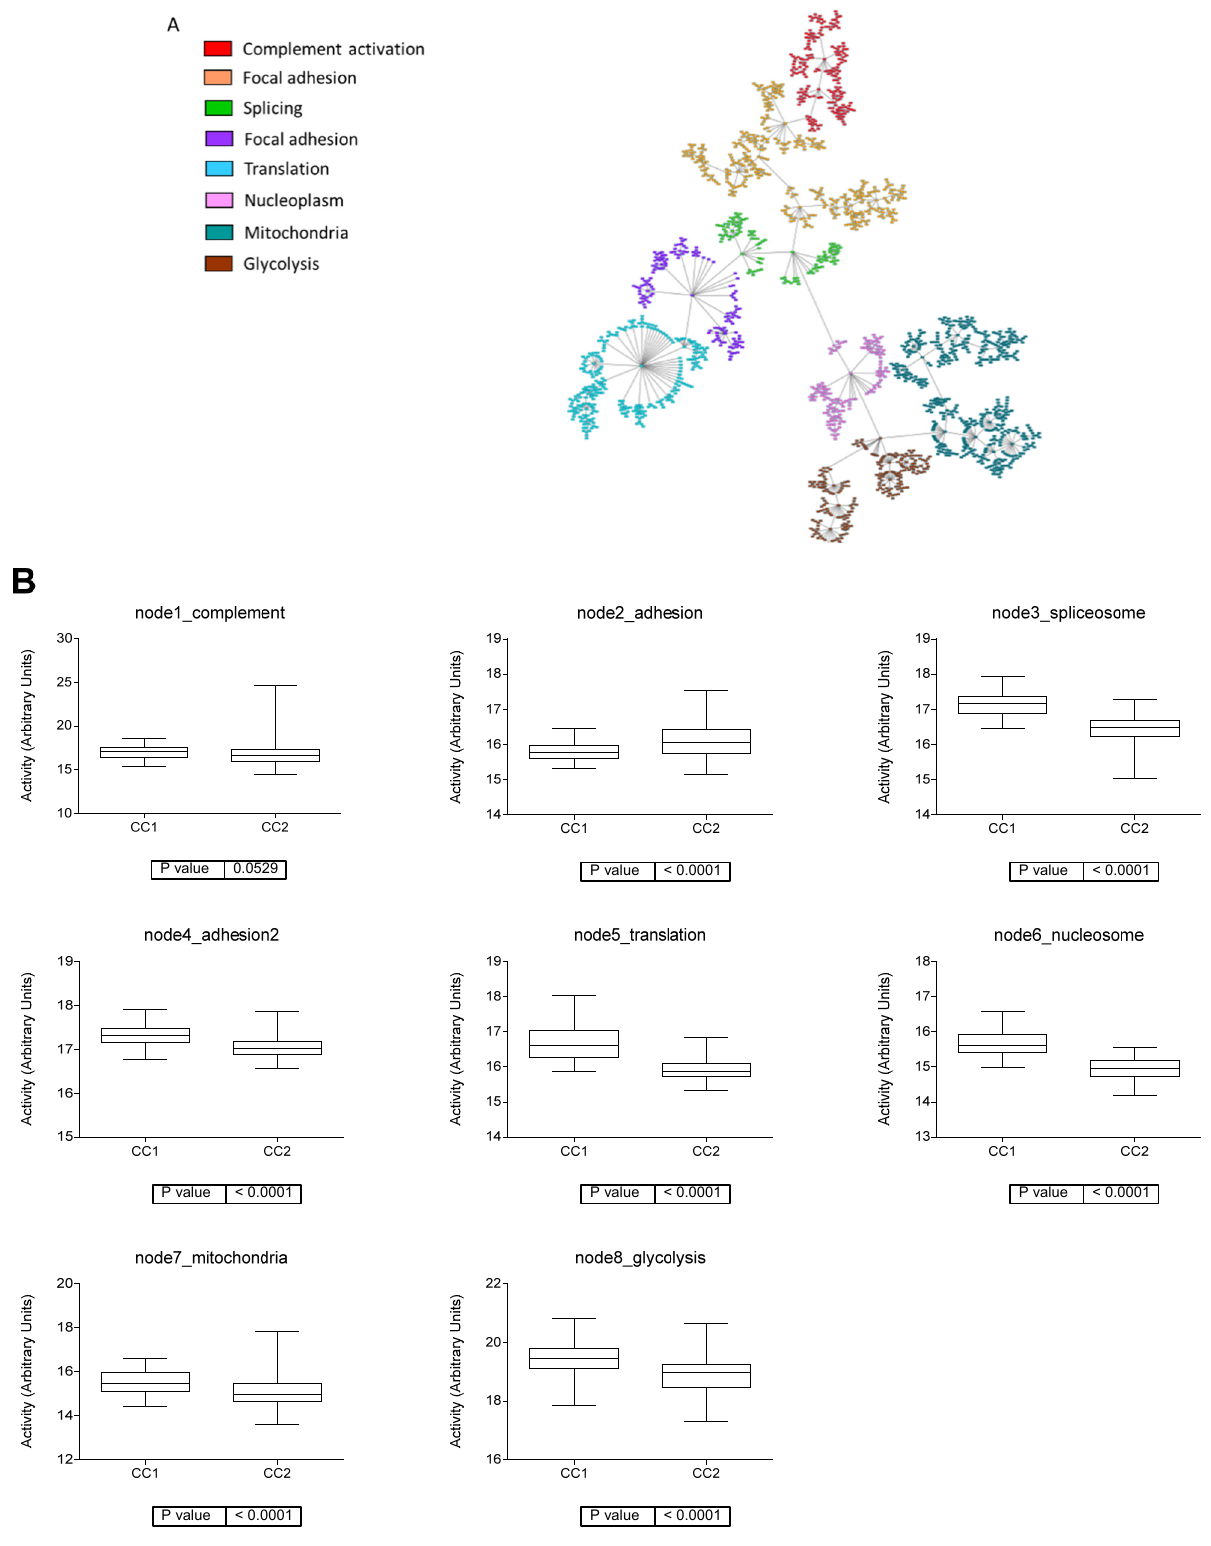
Figure 4. Systems biology analysis of ccRCC proteomics data. ( A ). Network obtained in the proba- bilistic graphical model analysis from the proteomics data. ( B ). Boxplots of functional node activities comparing the two proteomics ccRCC groups.